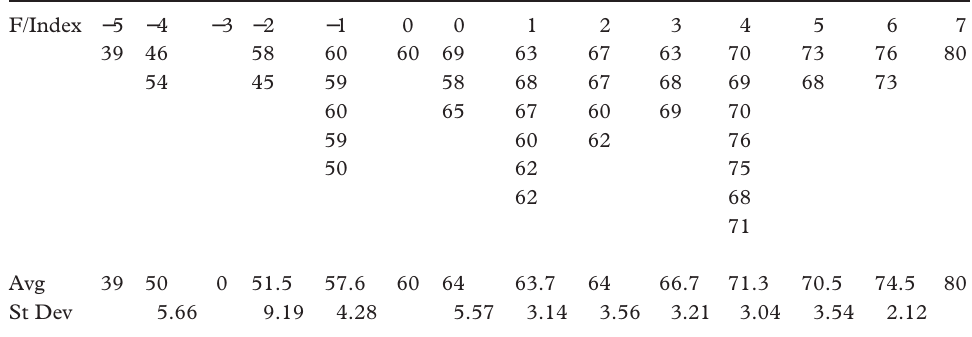
Table 1. Mapping of non-compensated DSandEN marks to comments